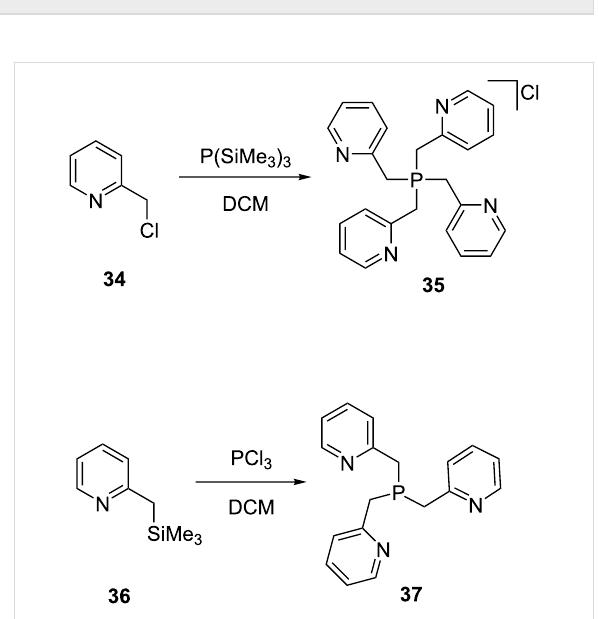
Scheme 5: Synthesis of diphenylphosphine-substituted triazine ligands.